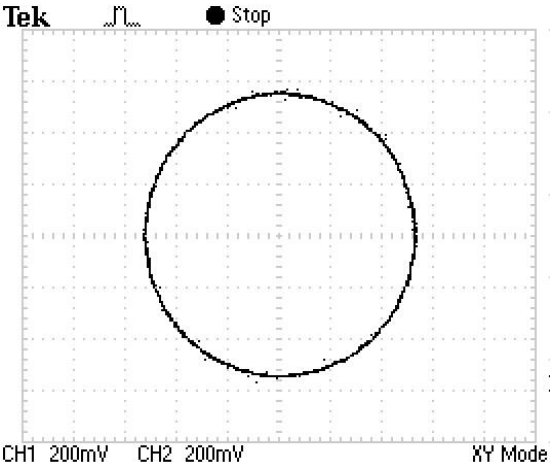
Appl. Sci. 2018 , 8 , x FOR PEER REVIEW Figure 10. Output Lissagous circle of the 3DOFLM system. Figure 10. Output Lissagous circle of the 3DOFLM system. Figure 10. Output Lissagous circle of the 3DOFLM system.